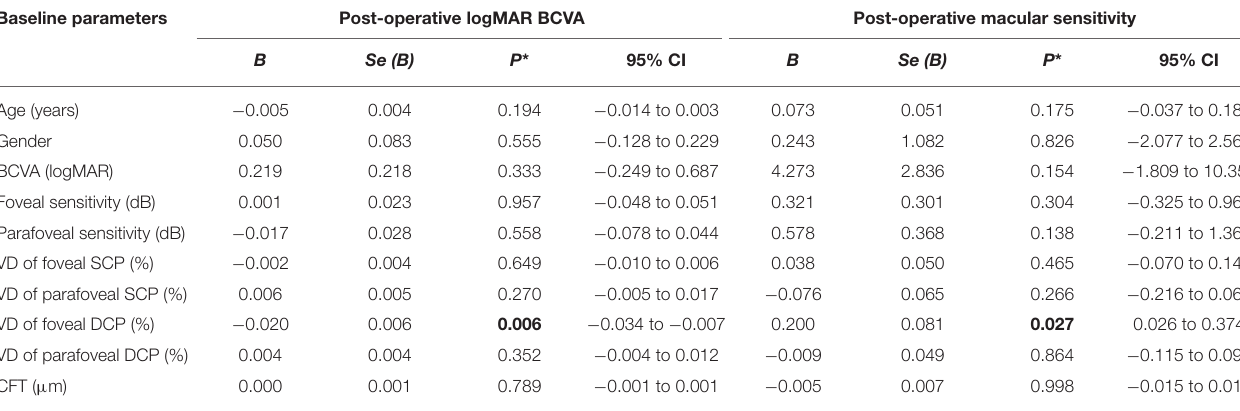
TABLE 3 | Multiple linear regression model of post-operative logMAR BCVA or macular sensitivity and baseline ocular parameters. Baseline